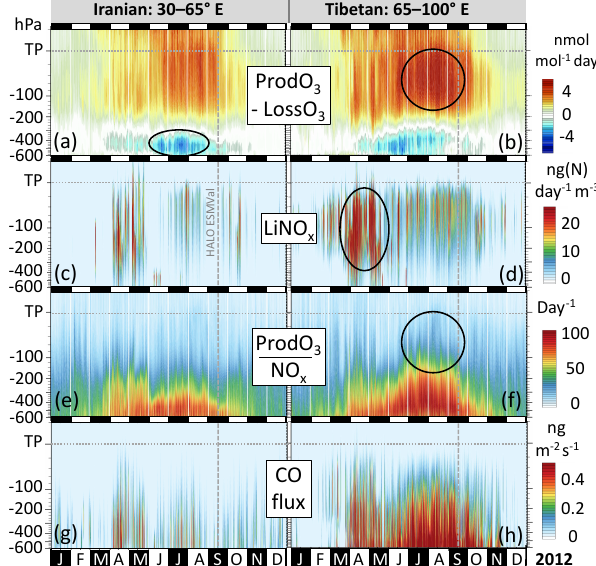
Figure 7. As in Fig. 5, but for different parameters related to net photochemical O 3 production (ProdO 3 − LossO 3 ). Lightning NO x (LiNO x ) emissions in the model are determined by parameterisa- tions for convection, lightning and NO x emissions per flash. CO flux reflects the concurrence of deep convective mass flux and CO mixing ratio, but as a simple product neither account for entrain- ment and detrainment of convection. Panels (e) and (f) highlight the non-linear dependence of O 3 production on NO x mixing ra- tios. Strong gradients indicate the transition between NO x -limited and NO x -saturated photochemical regimes, but are superimposed by the effects of other O 3 precursors. Individual profiles from pan- els (a) and (b) are shown in the